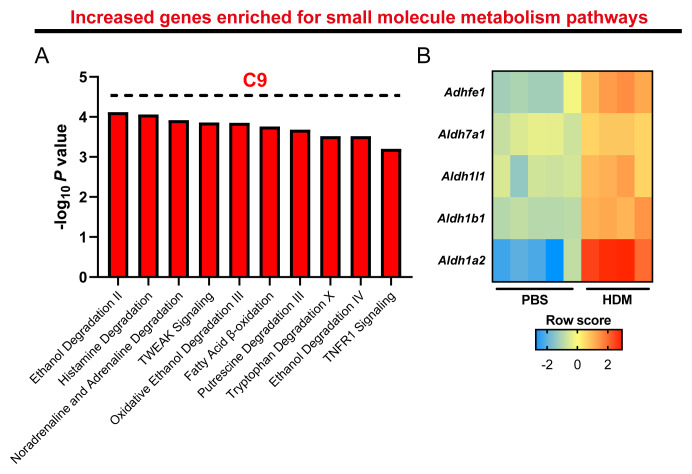
Increased expression AM
HDM genes enriched for small molecule metabolism pathways.(
A) Highly enriched small molecule metabolism pathways in cluster C9 of increased genes in AMs
HDM. (
B) Expression of representative genes for the pathway annotations shown in (
A). Bar plot shows canonical pathway names and inverse enrichment Fisher’s exact
P values. Heatmap shows row-centred gene expression values (N=5 mice, PBS; N=4 mice, HDM).